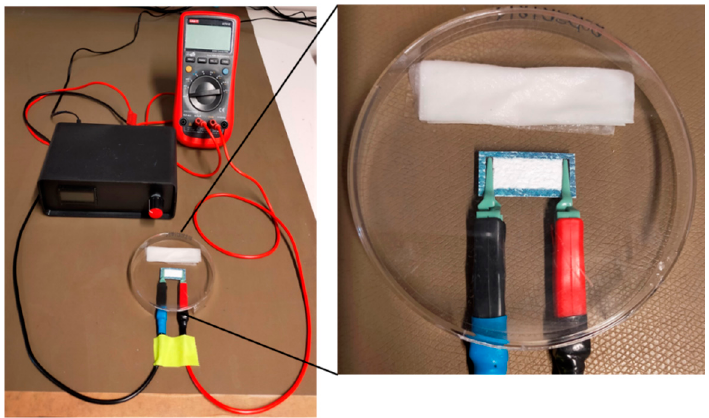
Figure 3. Photographs of fiber-electrophoresis experimental setup 1. The fiber-electrophoresis chip was placed between two crocodile clamps, next to a wetted wipe and covered by a petri dish to avoid evaporation. The clamps were connected to a stabilized voltage supply and a multimeter was integrated for current